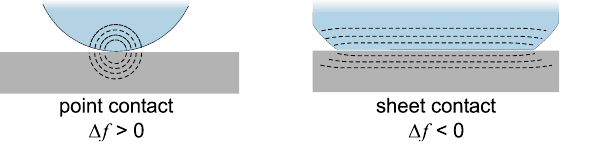
Figure 26. Point contacts and sheet contacts are characterized by spherical waves and planar waves, respectively.